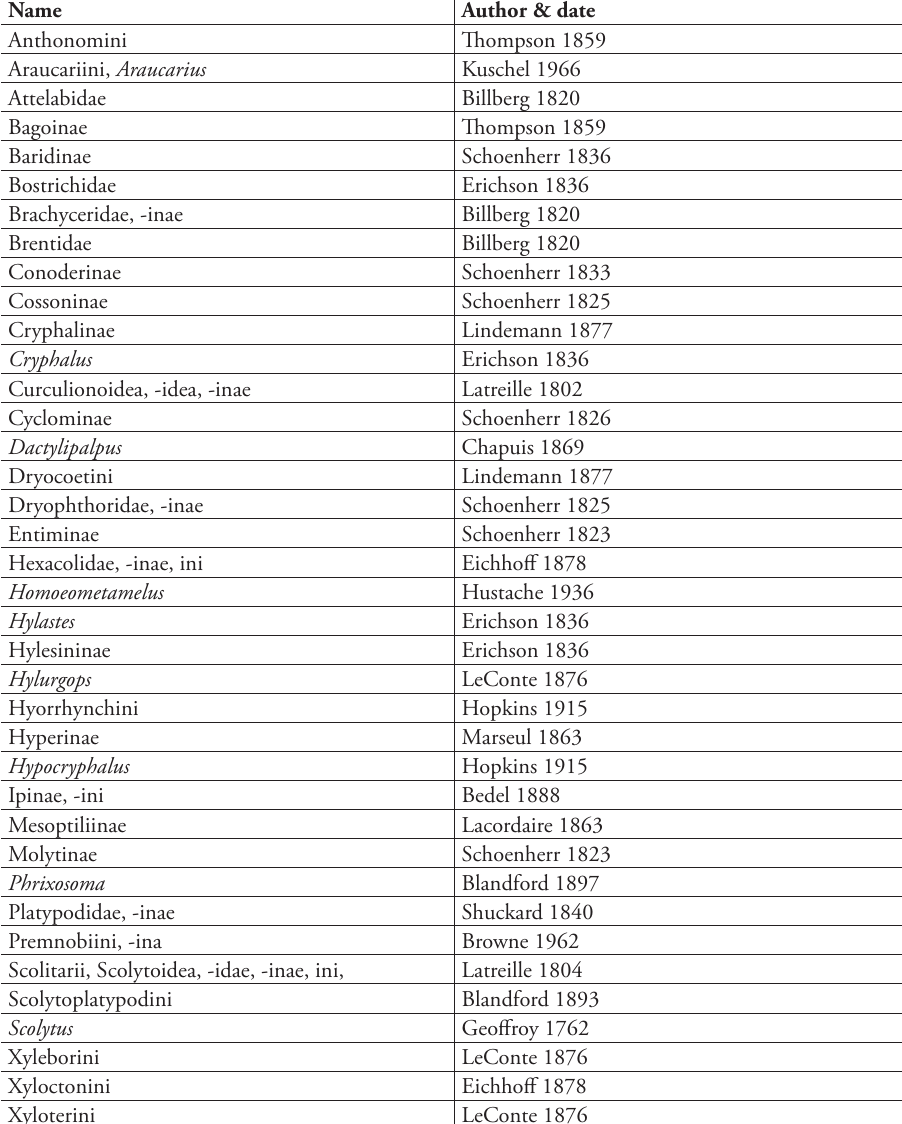
Table 1. List of taxa mentioned in the text, with author and year of